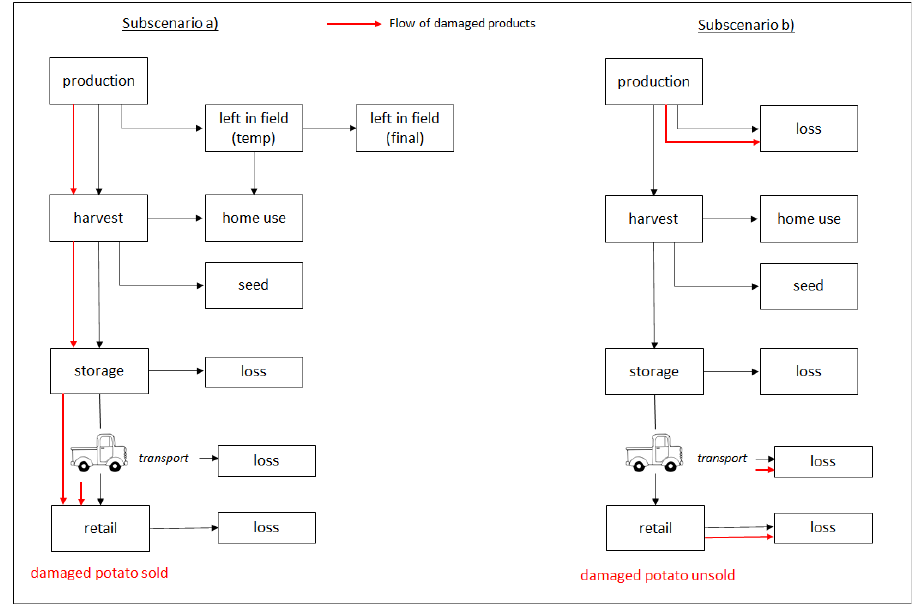
Figure 4. Flow Scheme with Subscenarios (a) and (b). Both Subscenarios Can Hold for All 4 Sce-